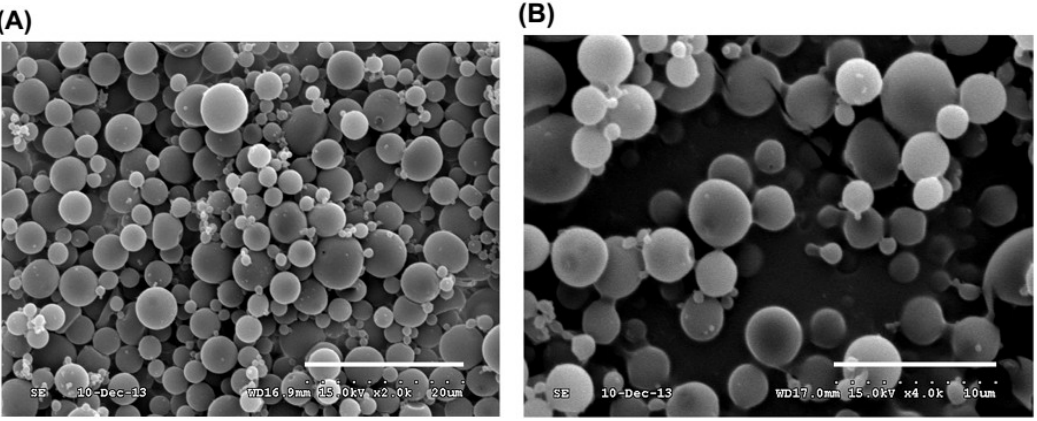
Figure 3. In vitro release of rGAPDH or PLE peptide from PLG microparticles. The rGAPDH (Lane 1), PLE peptide (Lane 2), as well as released samples of PLG-PLE/rGAPDH microparticles ( A ) and PLG-rGAPDH microparticles ( B ) on Days 6 (Lane 3), 12 (Lane 4), 18 (Lane 5), 24 (Lane 6) and 30 (Lane 7) were analyzed by